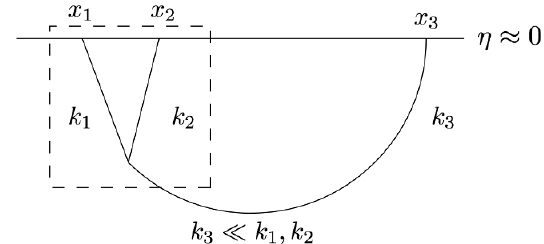
Figure 2 . NG in single-(cid:12)eld